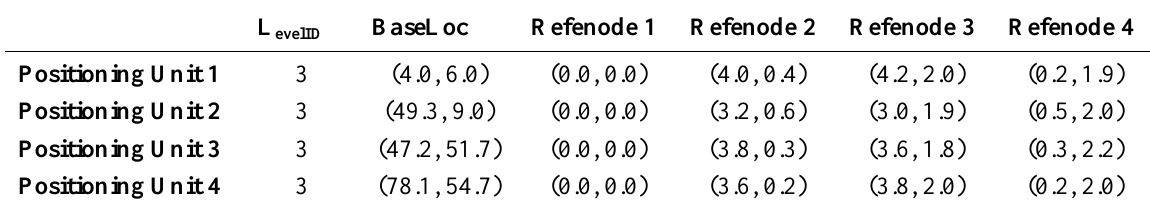
Table 8. The configuration parameters of the reference nodes in the third